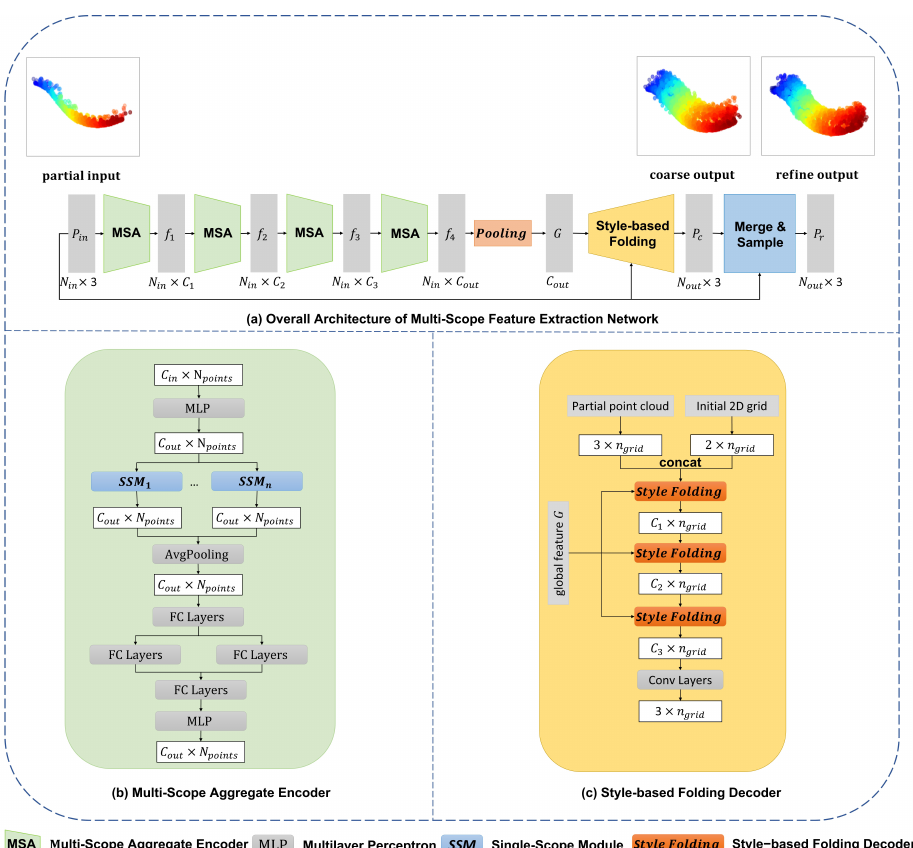
Figure 7. Overall architecture of the proposed Multi-Scope Feature Extraction Network